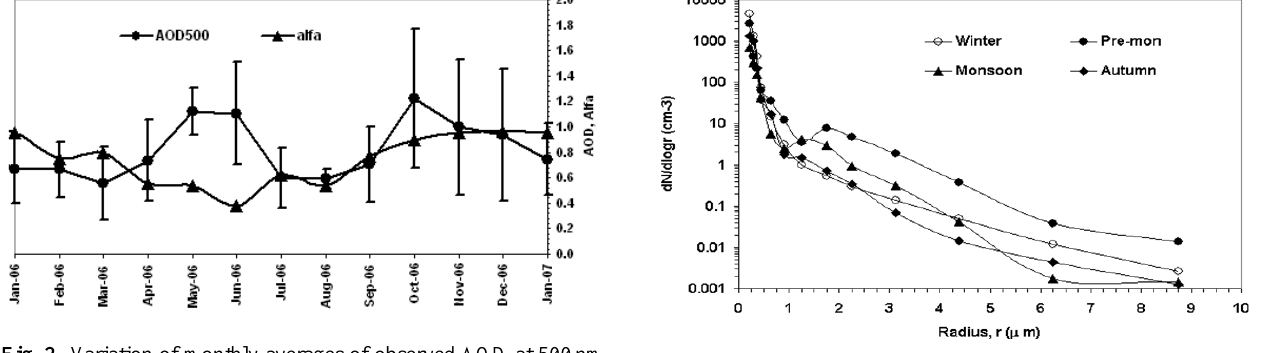
Fig. 3. Aerosol number size distribution over Delhi during different seasons during 2006.